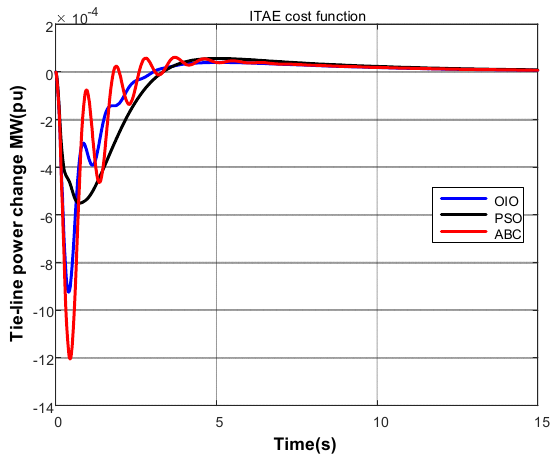
Figure 10. Change in frequency of area ‐ 2 for ITSE. Energies 2017 , 10 , 2134